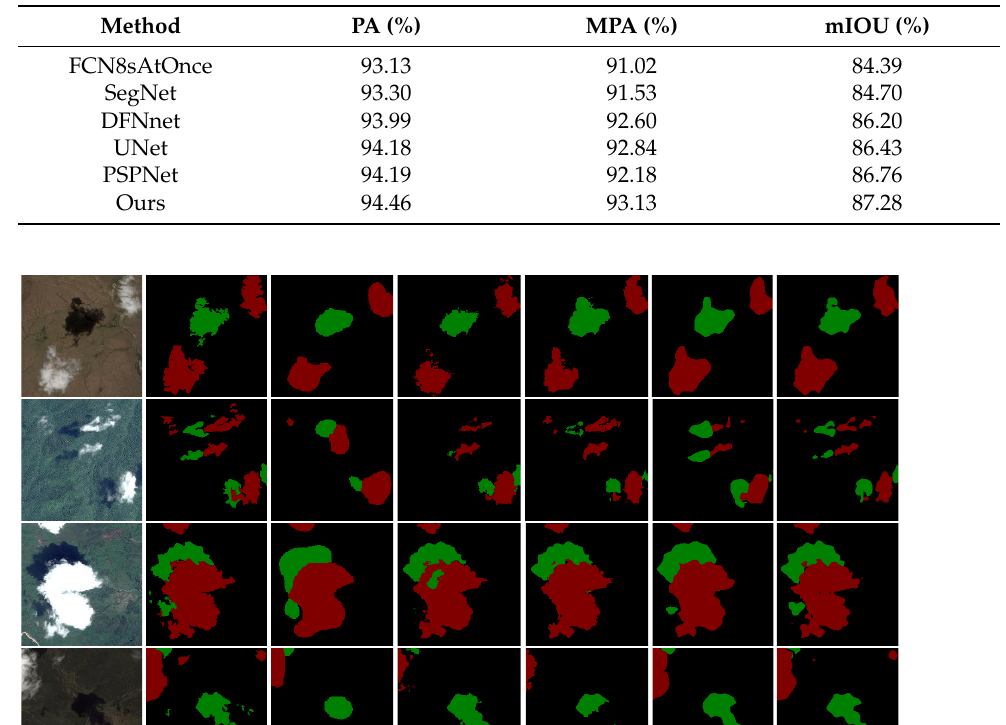
Table 4. Comparison of evaluation indexes of different models in cloud and cloud shadow dataset.